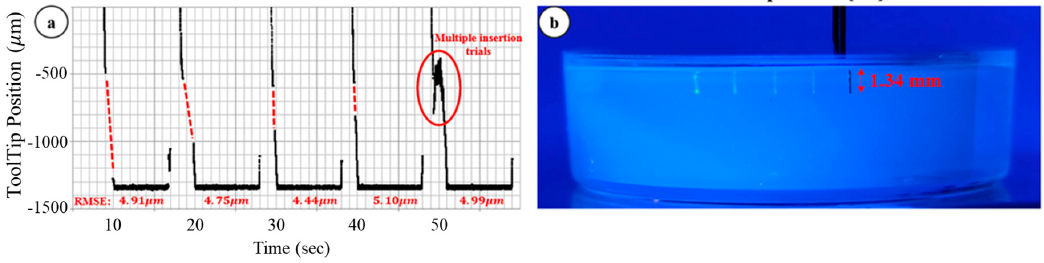
Figure 4. Preliminary 10% gelatin phantom injection test: ( a ) distance tracking data that has blind area caused by surface deformation, ( b ) five consecutive injection trials on a gelatin sample. The preset penetration depth was 1.34 mm.